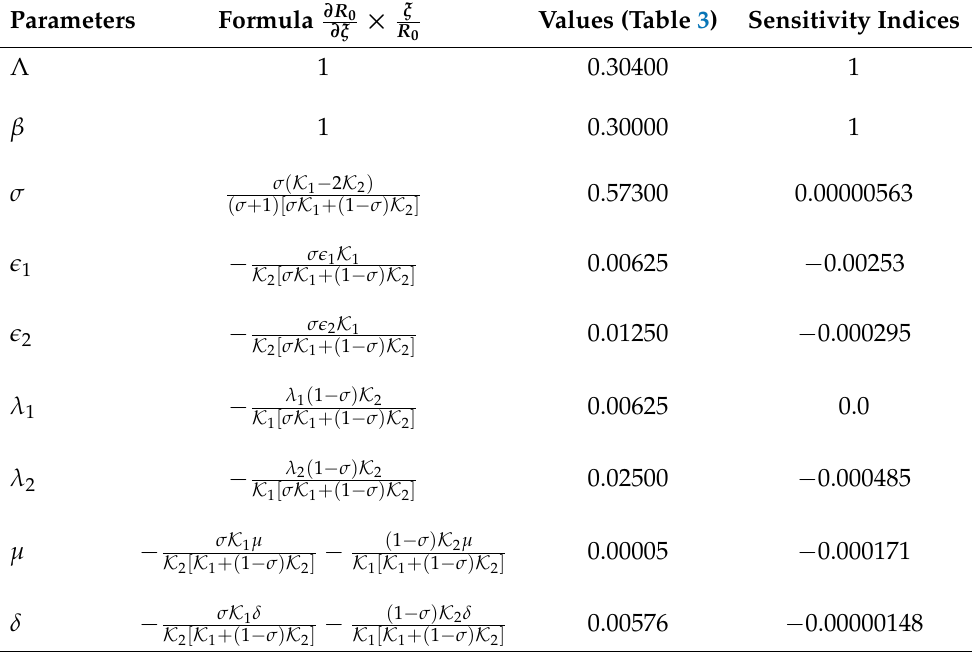
compared to the parameters R 0